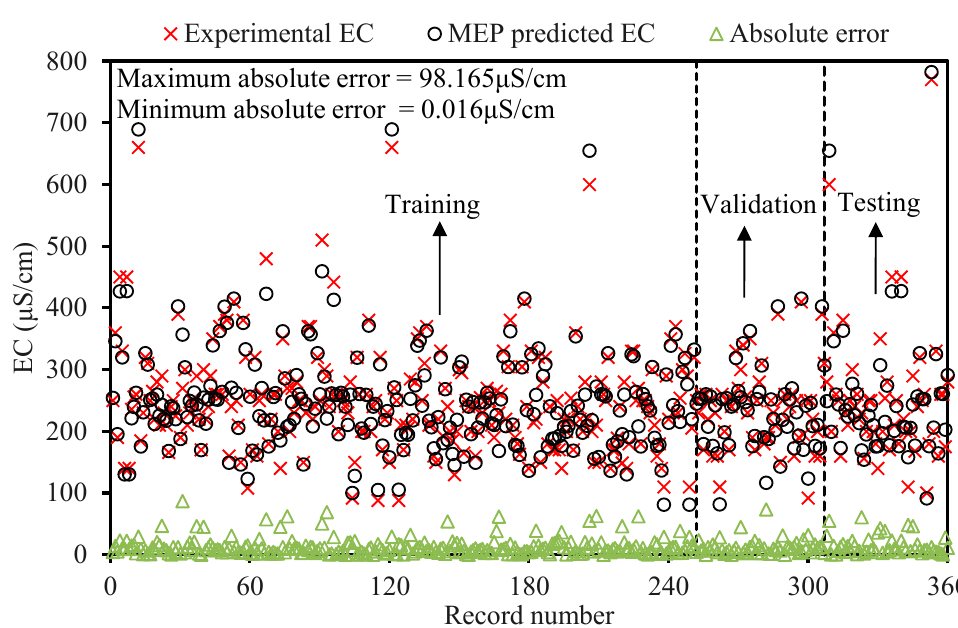
Figure 4. Absolute error plot of MEP model established for EC.